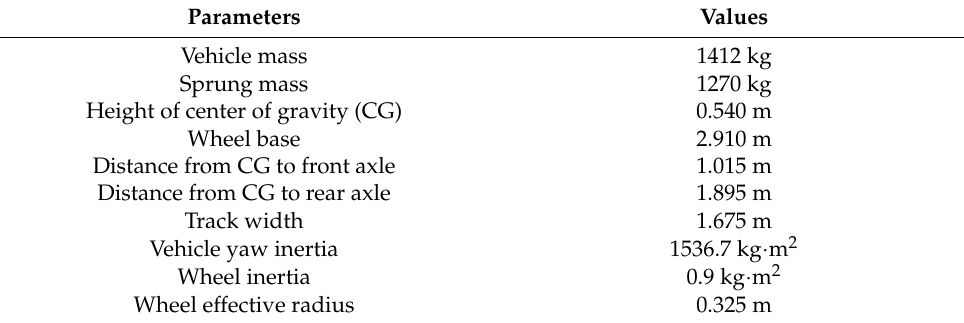
Table 4. Noise signals.